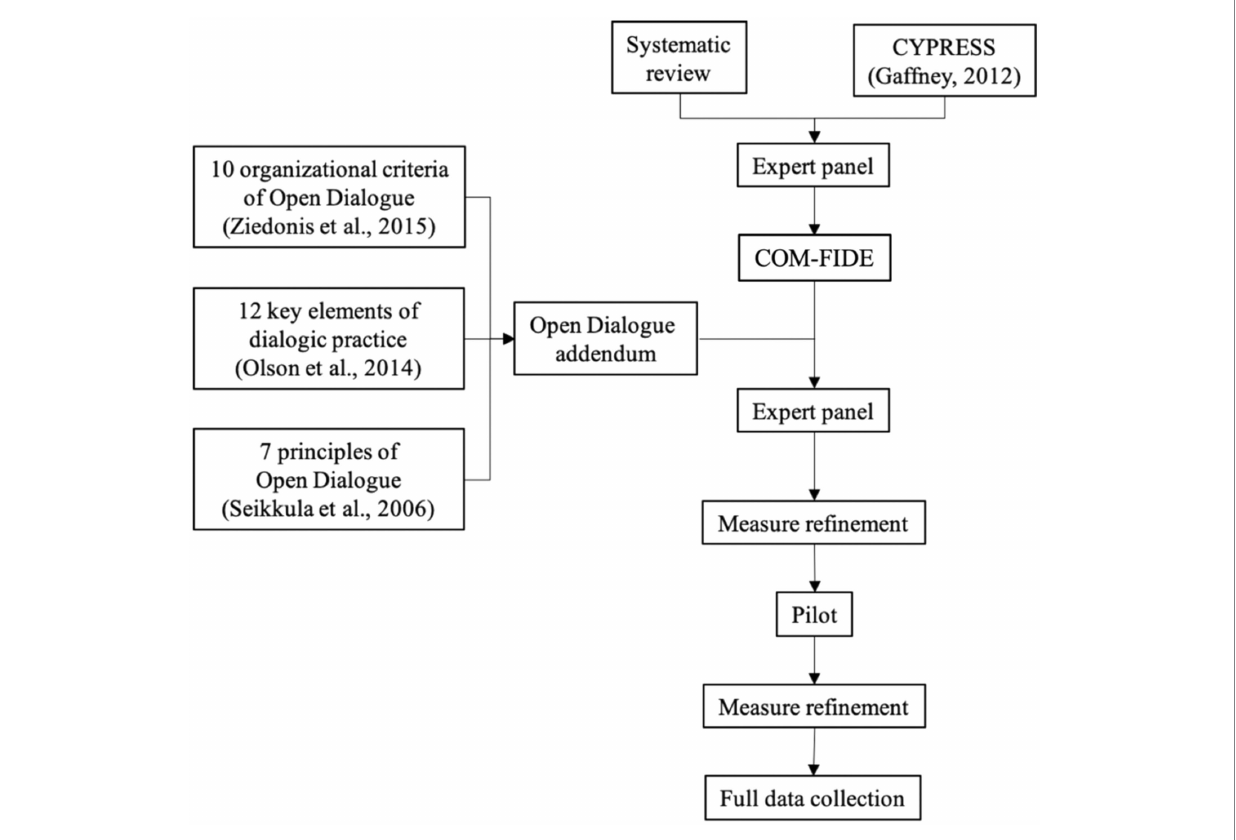
FIGURE 1 Community Mental Health Team Fidelity Scale (COM-FIDE) development